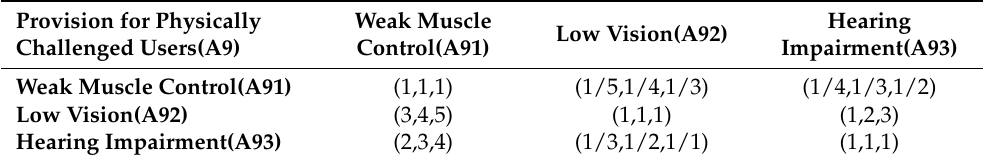
Table 13. Fuzzy based comparison matrix associated with the sub-criteria in relation to the Provision for Physically Challenged Users (A9) criteria.